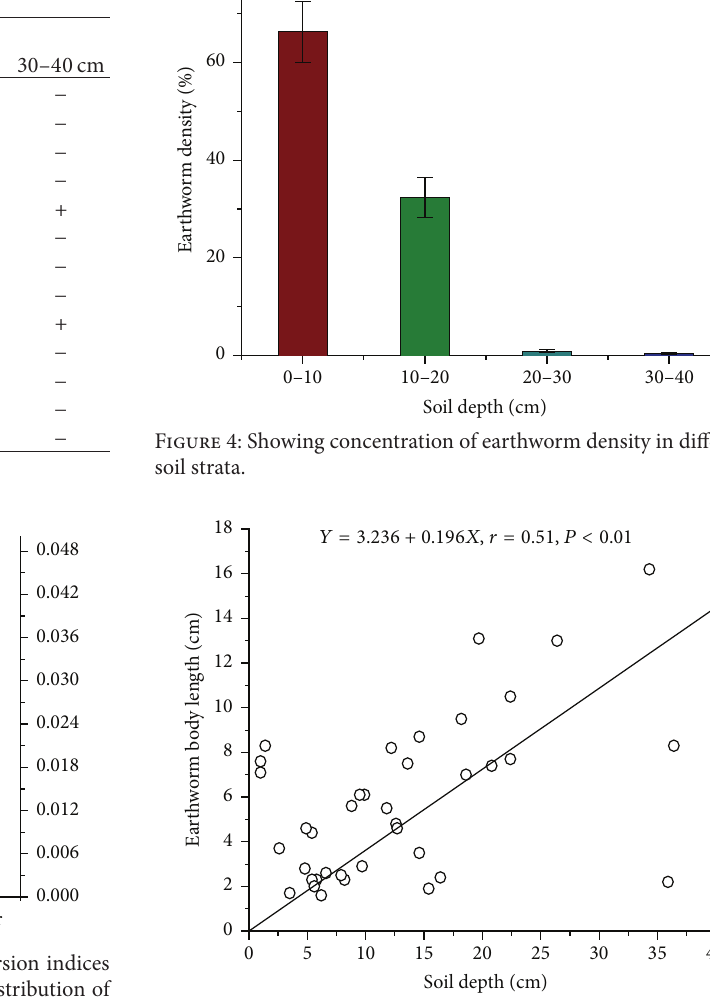
Figure5:Linearregressionanalysisshowingtheoverallrelationship between earthworm body length and soil depth for the earthworms of pineapple